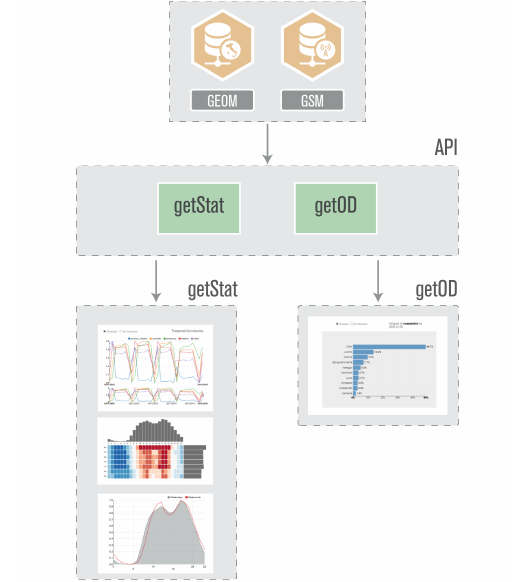
Figure 3. Graphical representation of the interactions between APIs and the data archiving system, and between APIs and the analysis showed on the web platform.